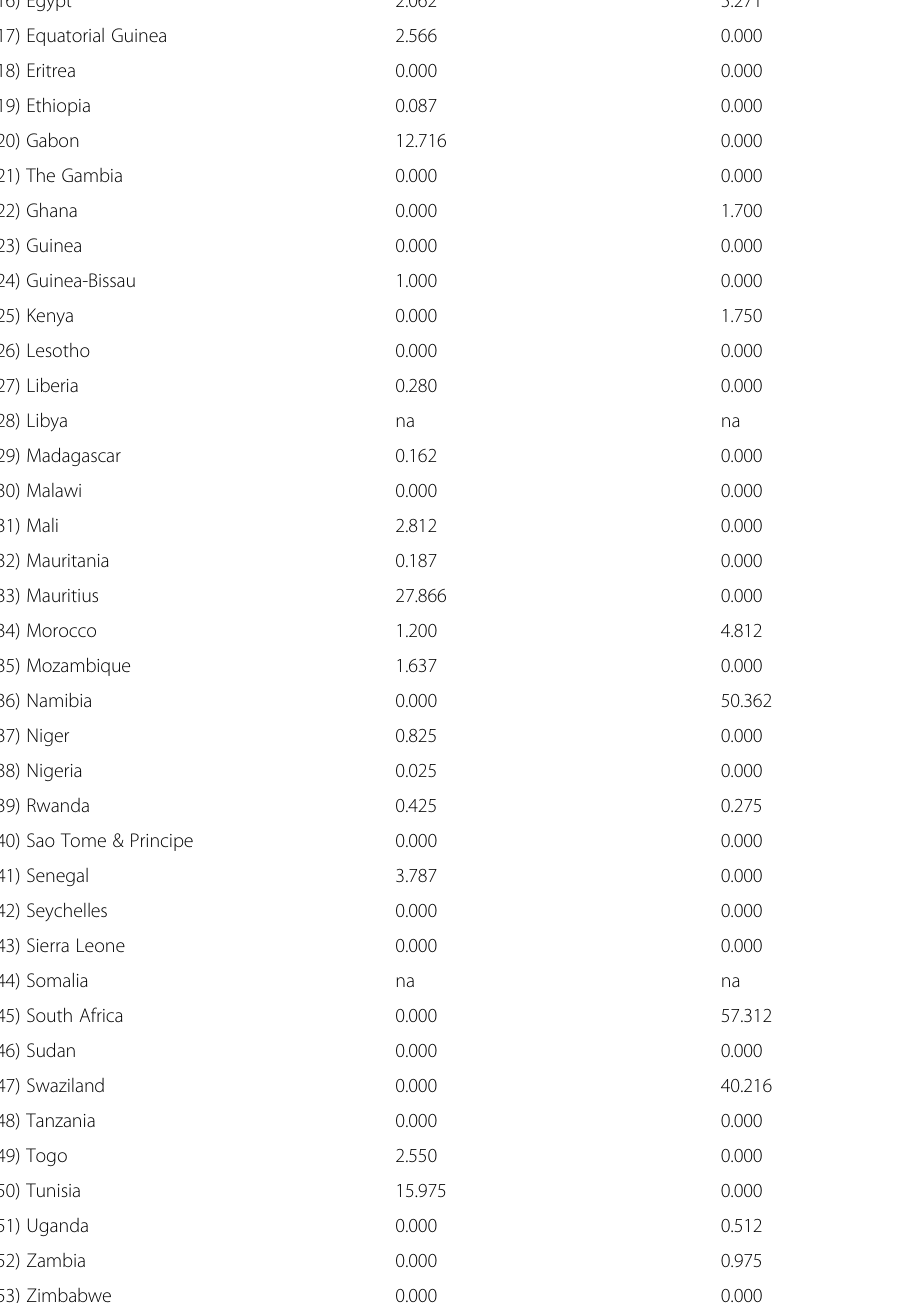
Table 12 Country-specific average values from information sharing bureaus